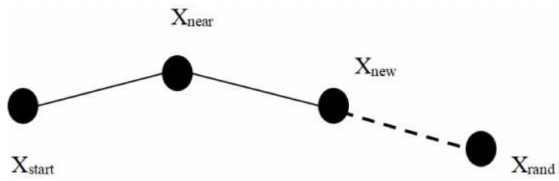
Figure 3. Schematic diagram of RRT algorithm.